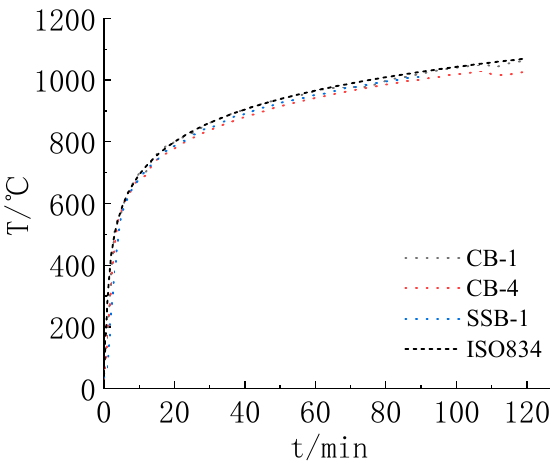
Figure 11. The time history curves of furnace temperature.